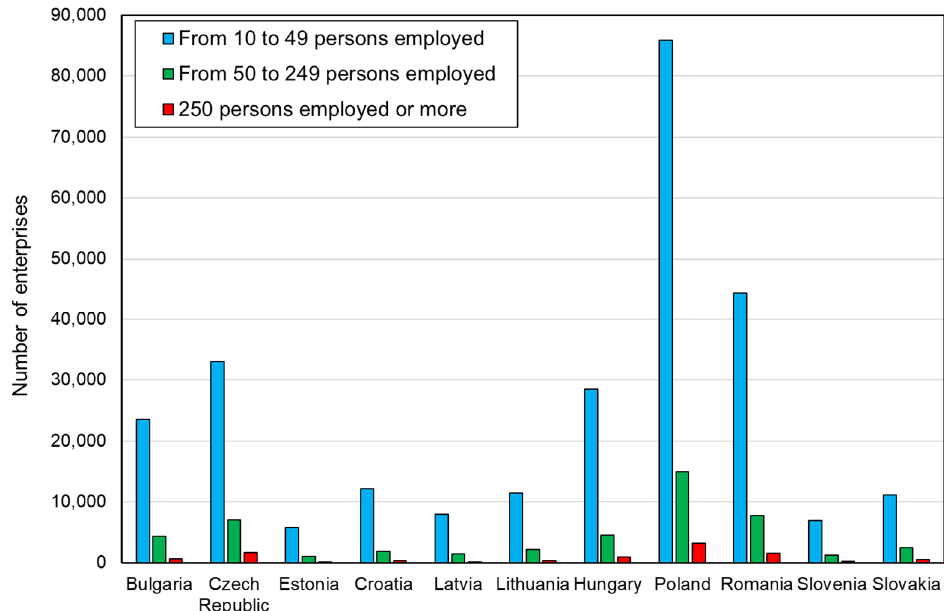
Figure 1. Overview of the number of small, medium-sized and large enterprises in individual CEE countries.